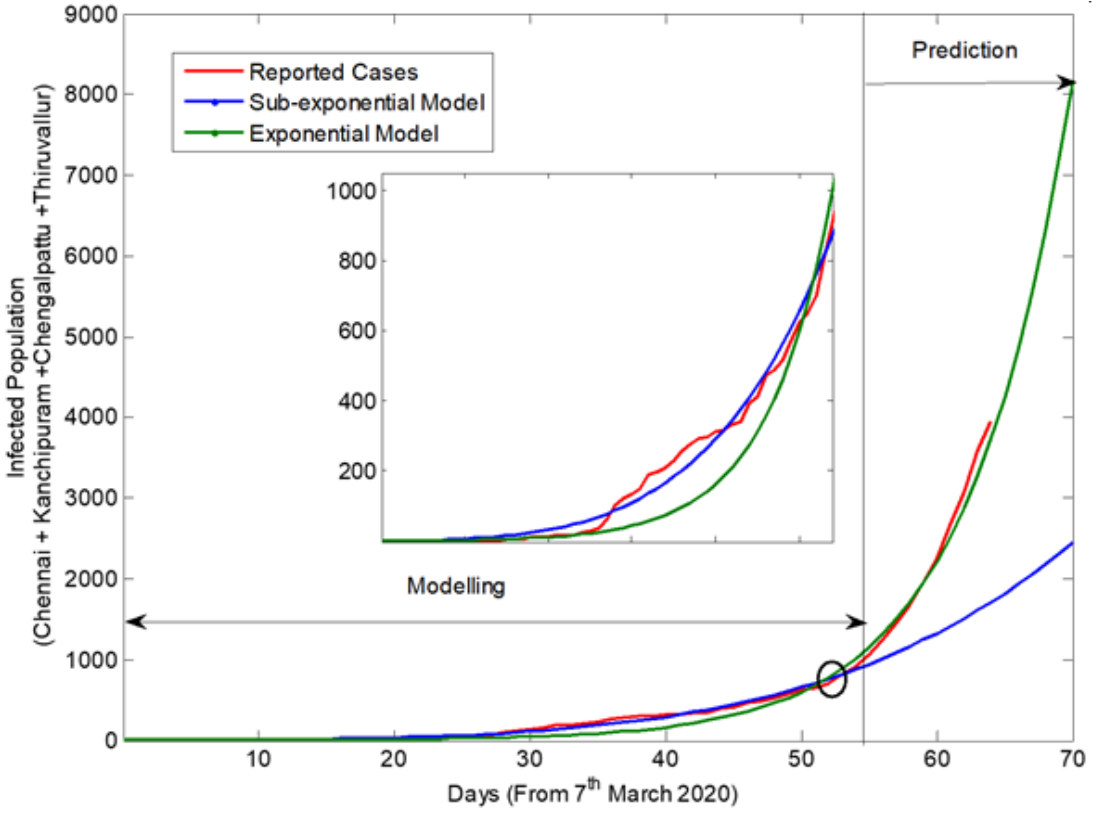
Figure 3. The reported number of coronavirus disease cases (includes effect of intervention), and the output of the subexponential and the exponential models, shown as a function of time.